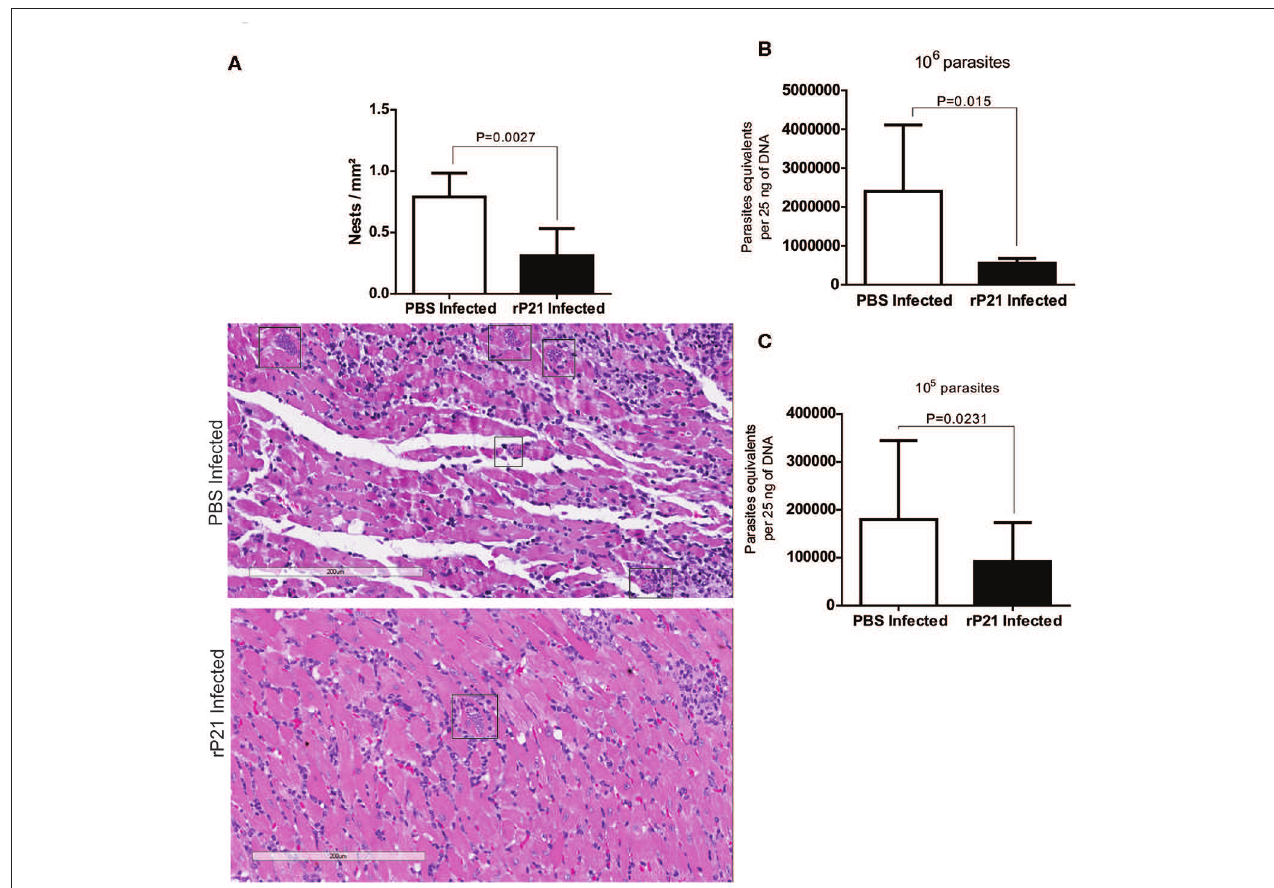
FIGURE 3 | In vivo rP21 treatment reduces parasite load in heart tissue. (A) Treatment with recombinant protein decreases amastigote nests in cardiac tissue. Representatives images with amastigotes nests highlighted in rectangles. (B,C) qPCR quantification shows reduced parasite load in the hearts of 10 6 and 10 5 T. cruzi -infected mice that were treated with rP21. Data are expressed as mean ± standard deviation of experiments performed in triplicate. Significant differences were determined using Student’s t -test (two-sided) (b) and Mann-Whitney test (c). Differences were considered significant when p <